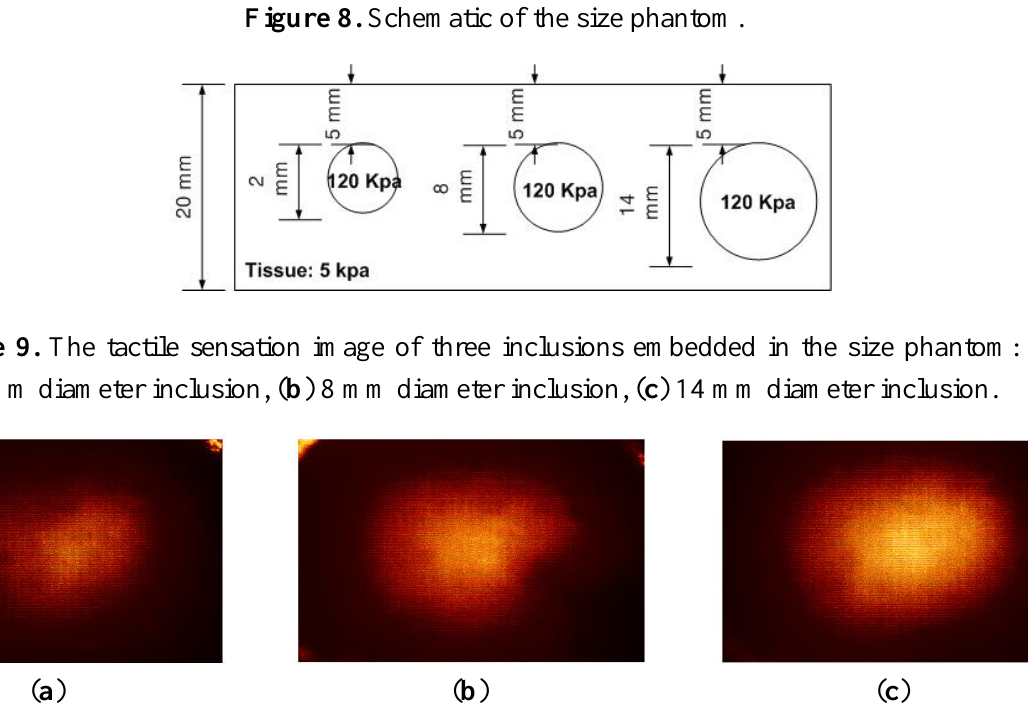
Figure 10. Error bar chart of the estimated relative diameter size of each